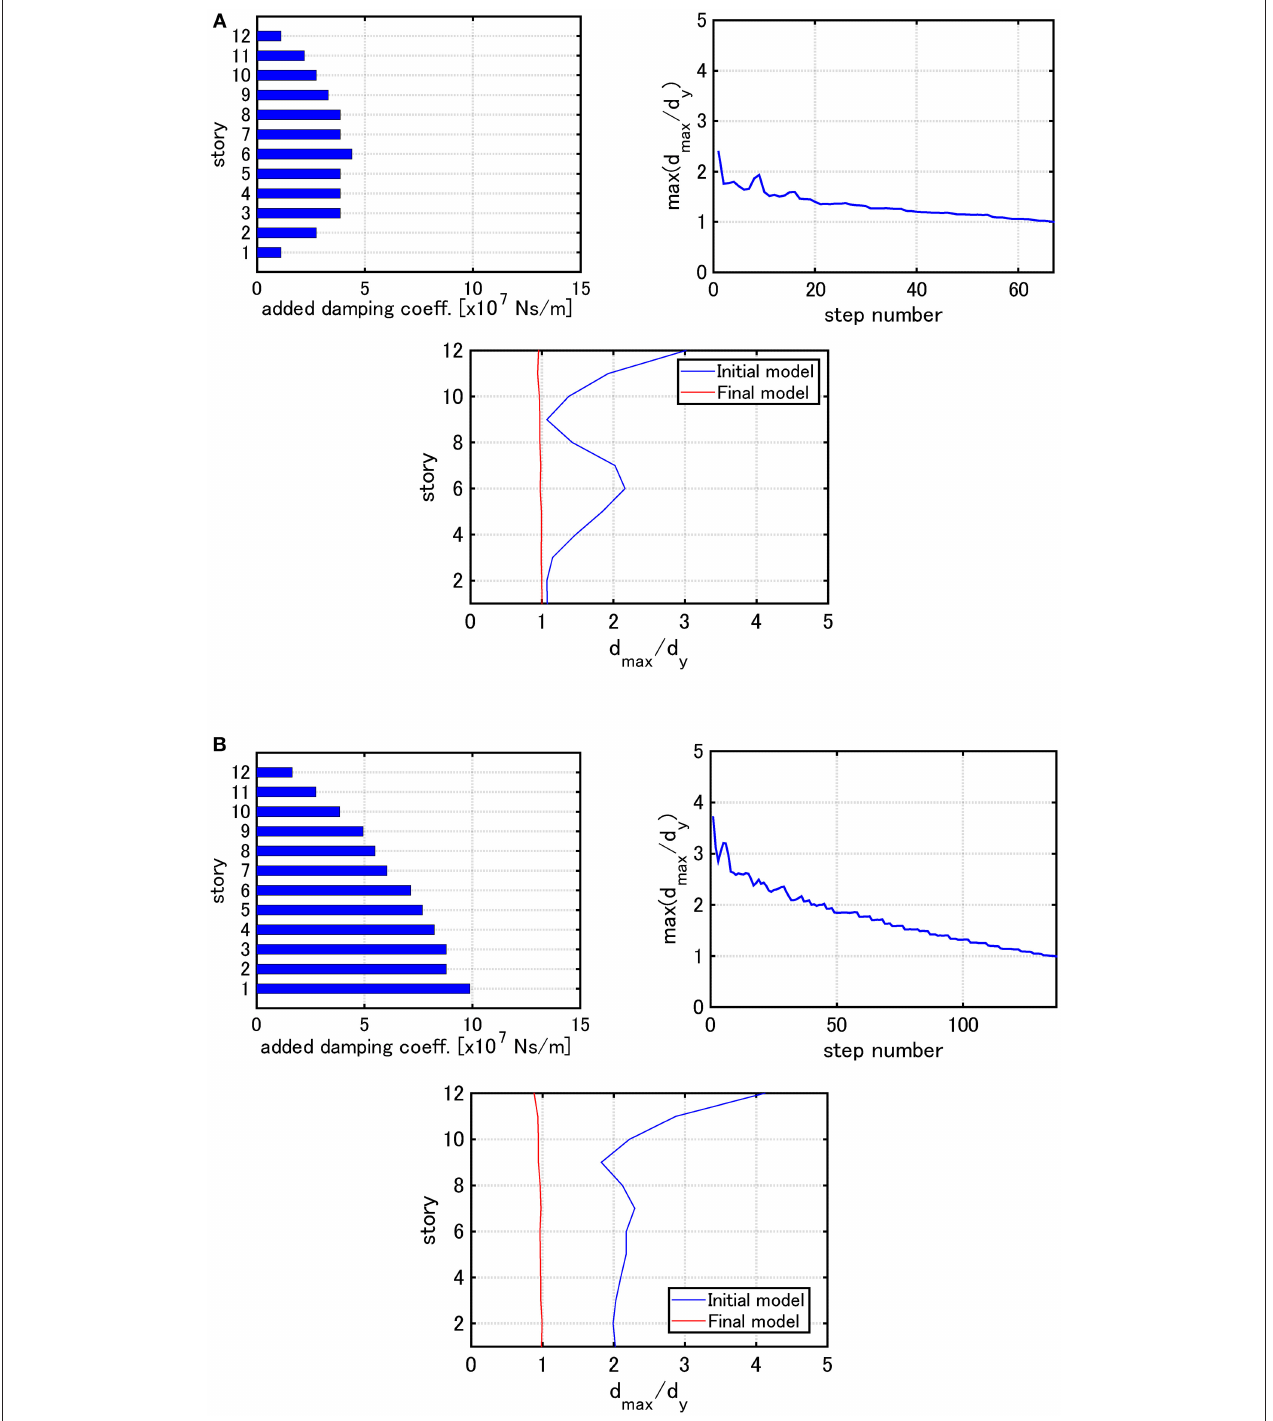
FIGURE 7 | Distribution of added damping coefficients, max ( d max , i / d y ) with respect to step number and the distribution of d max , i / d y under the critical double impulse for Model 2 (Problem 1): (A) V = 0.84[m/s], (B) V = 1.23[m/s].